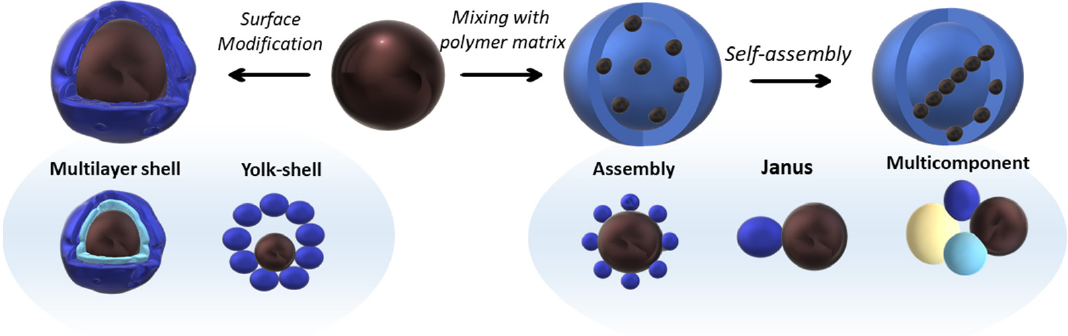
Figure 2. MNC structure types. Multilayer shells and yolk–shell are the subtypes of core–shell MNCs. Assembly, Janus, and multicomponent are self-assembly structural types.